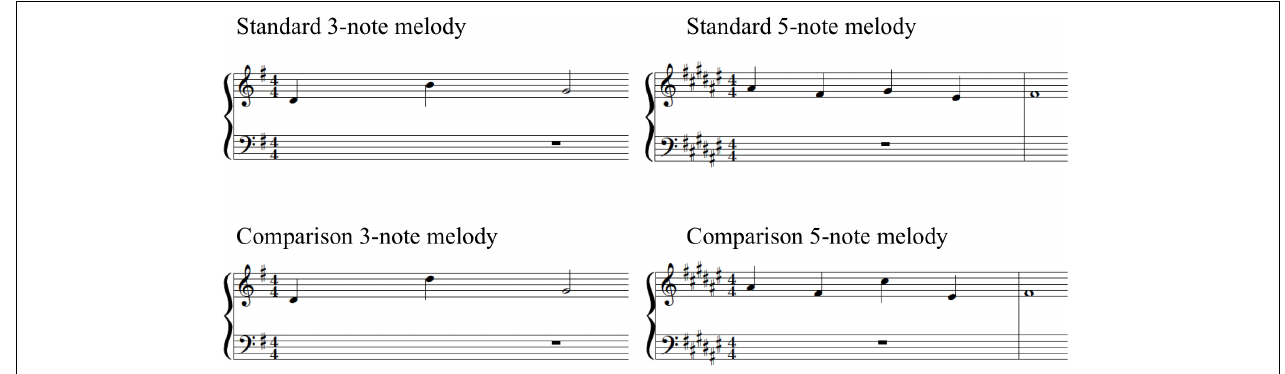
FIGURE 2 | Musical notation for standard and comparison versions of one example 3-note melody and one example 5-note melody.